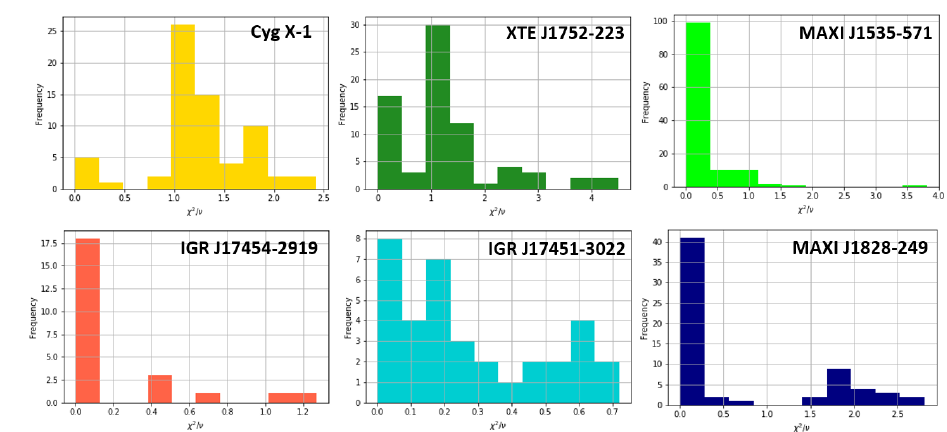
Fig. 1. Distribution of reduced chi-squared values of each candidate.